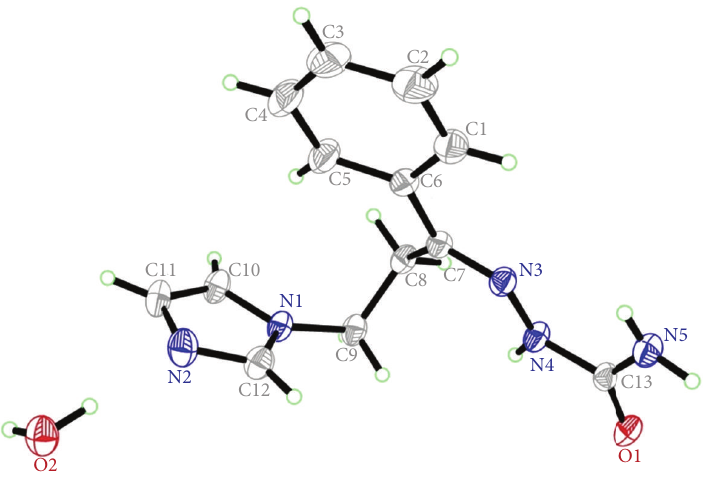
Figure 2: ORTEP diagram of compound 6g drawn at 50% ellipsoids for nonhydrogen